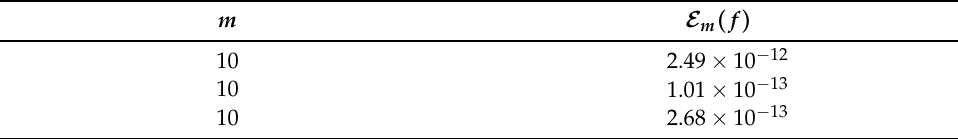
Table 5. Example 4: Errors in rational Gauss rules for computing approximations of (28) when A is a symmetric positive definite Toeplitz matrix. In the first row, we choose four equidistant poles α i ∈ { 0, − 2, − 4, − 6 } of multiplicity one. The second row displays the approximation error when the poles are allocated by (23) with α = 0 and (cid:96) = 4; the poles are α i ∈ {− 0.0396, − 0.4465, − 2.2398, − 25.2741 } of multiplicity one. The poles on the third row are obtained by using (23) with α = 0 and (cid:96) = 2. Then the distinct poles are α i ∈ {− 0.1716, − 5.8284 } of multiplicity